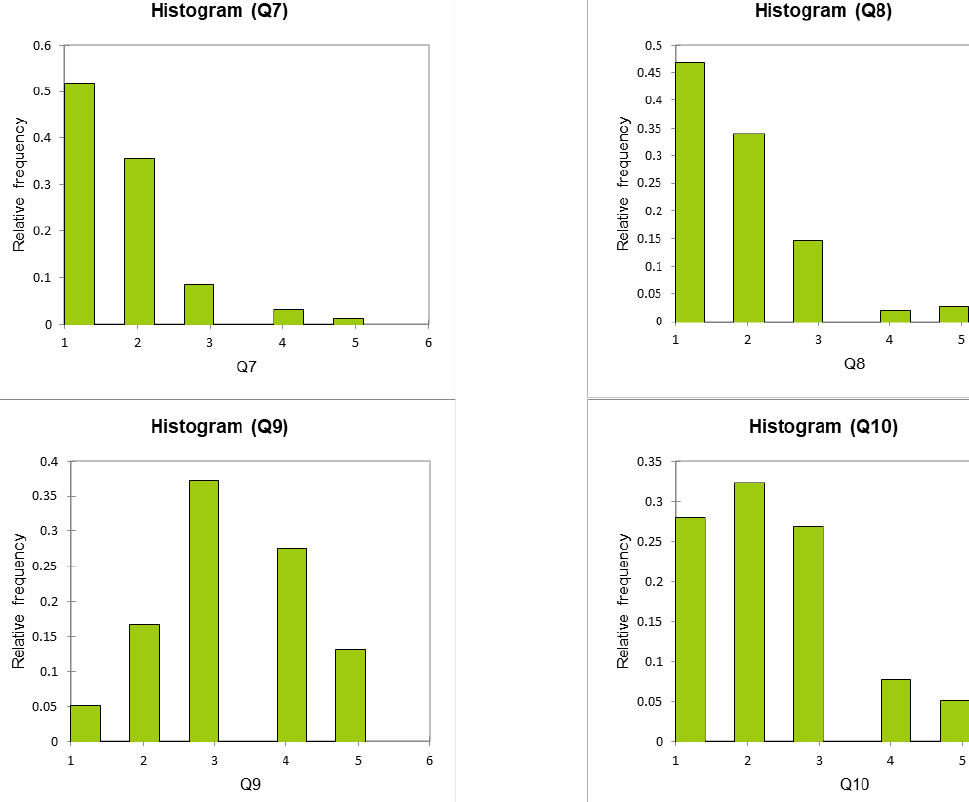
Figure 8. Histograms of Q7-Q10